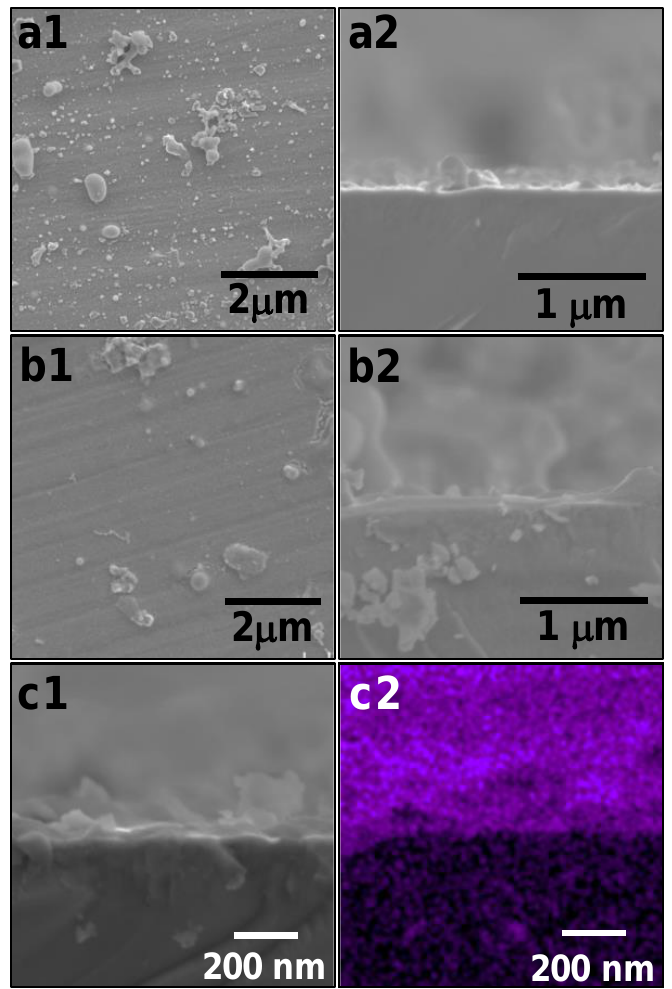
Figure 4. SEM images, SE images, and corresponding EDX elemental analysis of ZrO 2 ‑coated sub‑ strates. Images ( a1 ) and ( a2 ) show SEM images of the surface and cross‑section of ZrO 2 ‑coated sub‑ strates after one round of ZrO 2 ‑coating, respectively. Images ( b1 ) and ( b2 ) show SEM images of the surface and cross section of ZrO 2 ‑coated substrates after three rounds of ZrO 2 ‑coating, respectively. Images ( c1 ) and ( c2 ) show an SE image and an elemental map of Zr (purple) of the cross‑section of the substrate after rounds of ZrO 2 ‑coating,